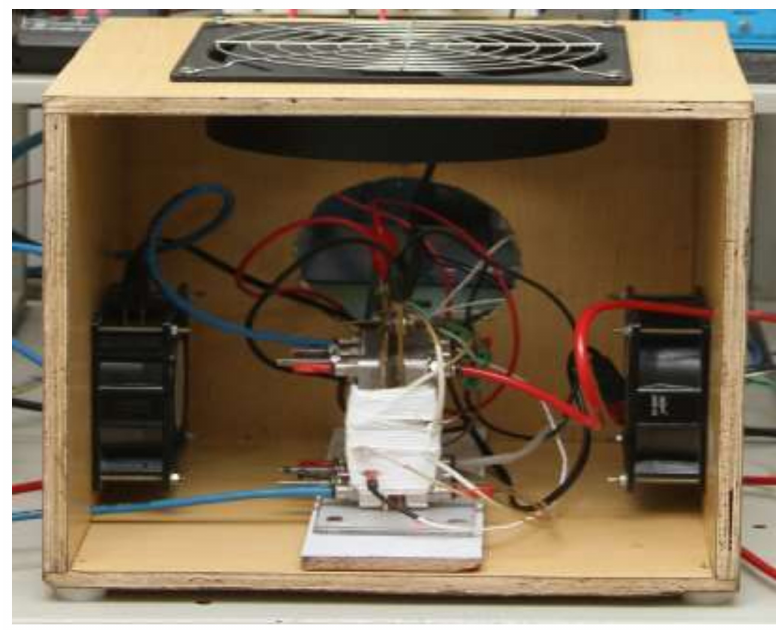
Figure 1. Real-time experimental setup of the direct-methanol fuel cell (DMFC) system.